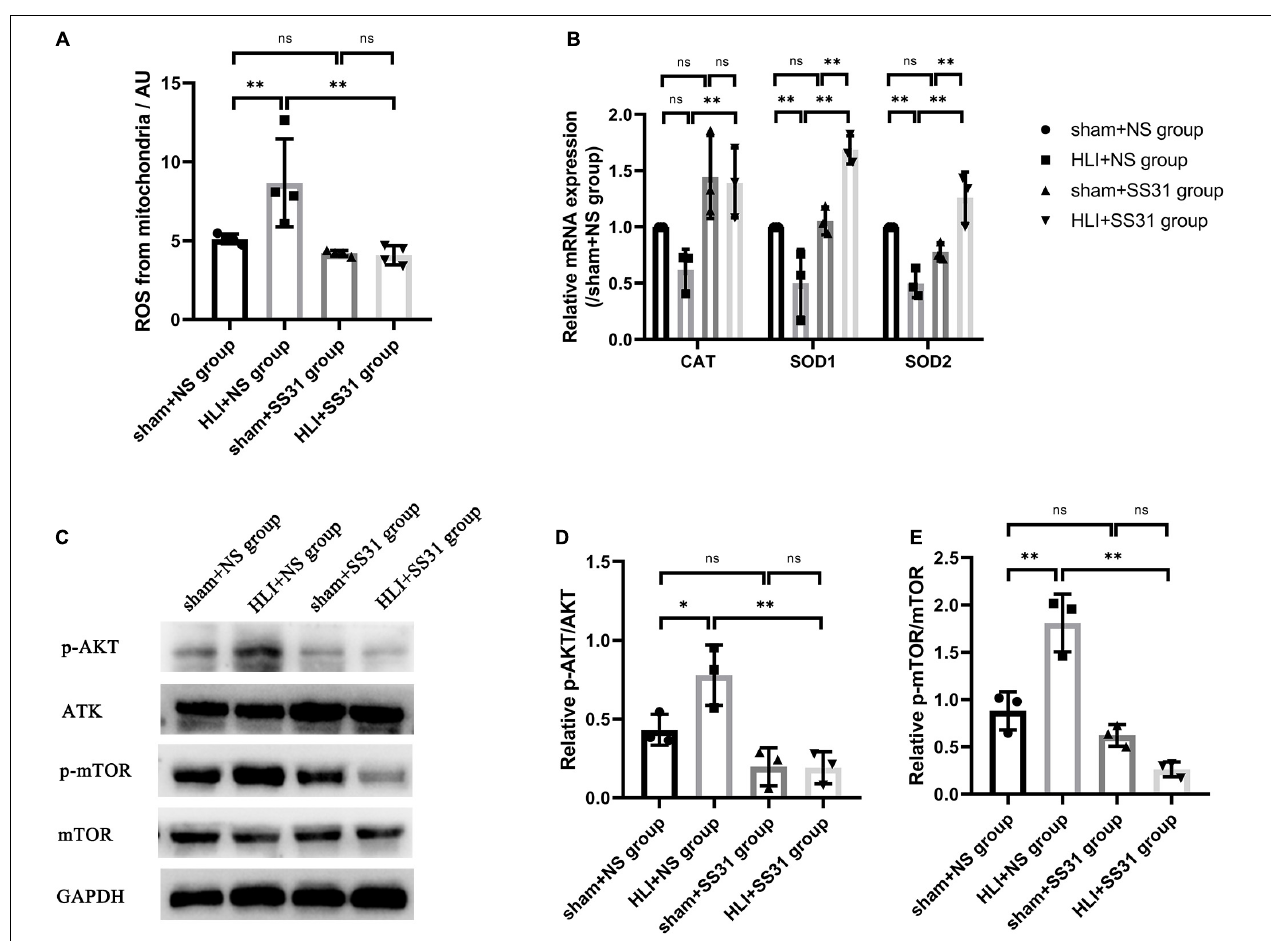
FIGURE 3 | SS31 alleviates oxidative stress and inhibits AKT-mTOR pathway in HLI mouse model. (A) A reactive oxygen species assay kit was used to quantify mitochondrial ROS production. (B) The relative mRNA levels of SOD1, SOD2, and CAT were determined by RT-qPCR. (C–E) The protein levels of phosphorylated AKT and mTOR in HLI mice were determined. The data were standardized on the basis of the GAPDH level, n = 3–4. ∗ p < 0.05, ∗∗ p <